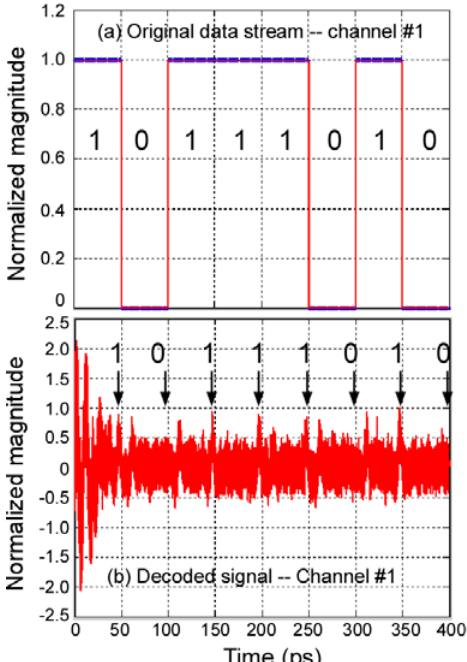
Figure 7. ( a ) the original #1 symbols (reshown from Figure 4(a) for better illustration); ( b ) decoded signal using the optical CDMA decoder with the code of [0 π 0 0 0 π π 0 π 0] for channel #1. Using edge-detection at the end of each 50-ps signal bit, the original channel #1 data stream 1 0 1 1 1 0 1 0 can be recovered.